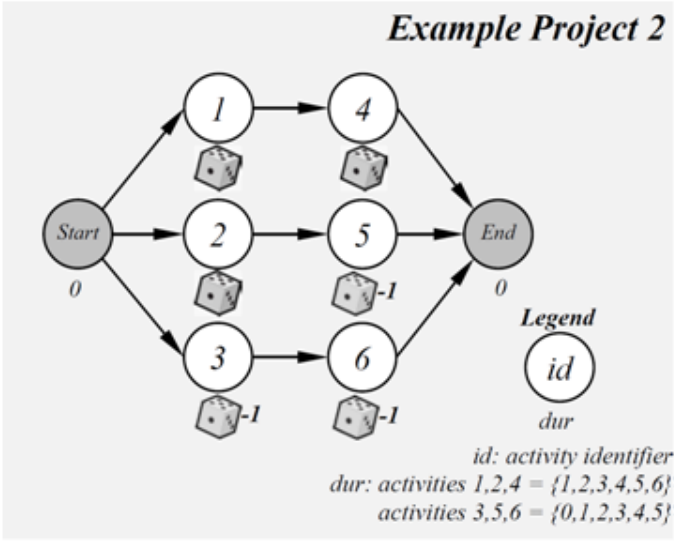
Figure 7. AoN network of the example project 2 assuming variable activity durations